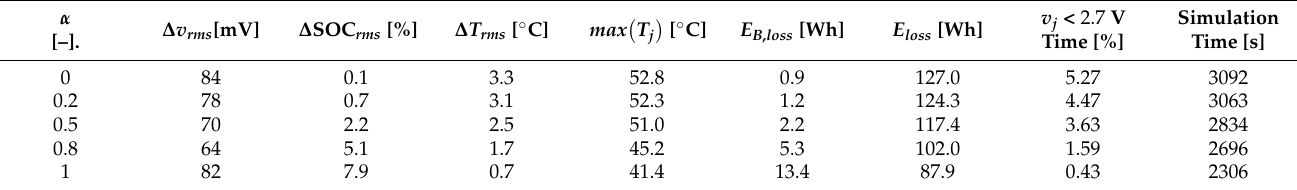
Table 5. Key metrics of dual balancing (SOC and temperature) results shown in Figure